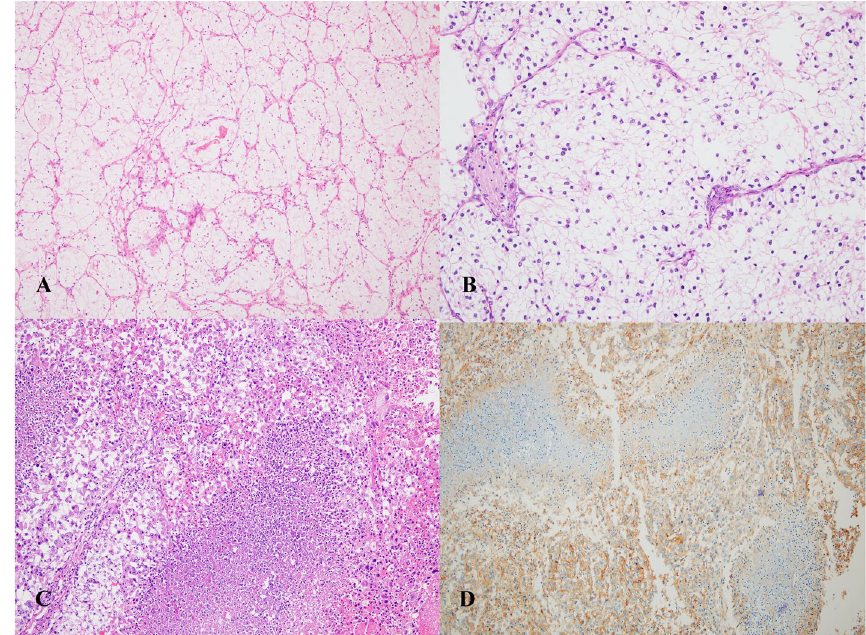
Fig. 2 Renal cell carcinoma (RCC) cells stained with hematoxylin and eosin (H&E). Clear cell RCC (ccRCC) ( A ); immune cells with ccRCC ( B ); necrosis with a sarcomatoid pattern ( C ); .B7‑H3 expression in sarcomatoid pattern ( D